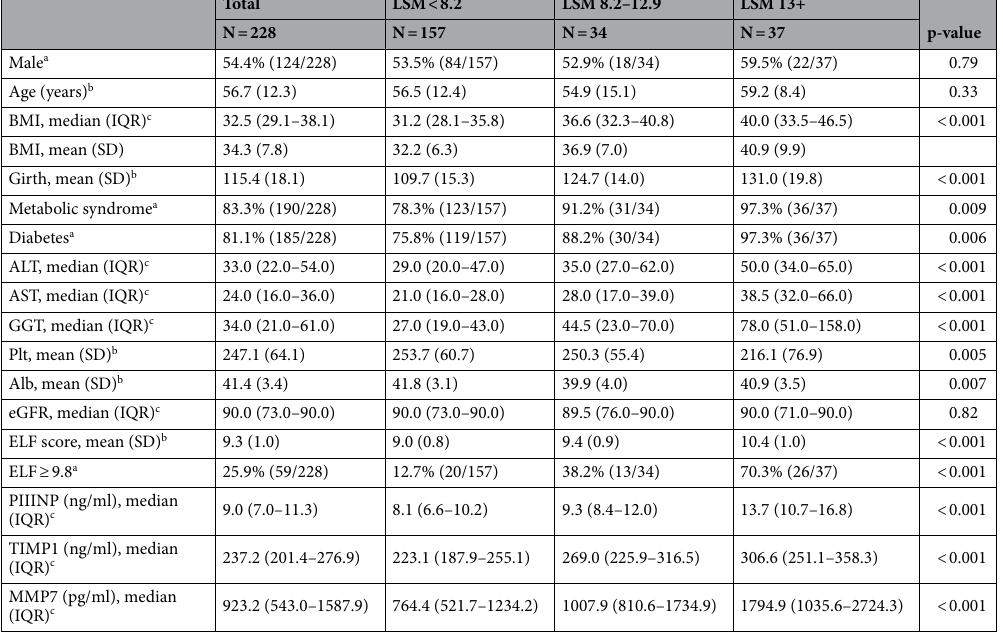
Table 1. Study cohort demographics and clinical parameters according to LSM category. Data are shown as mean (SD) or median (IQR) for continuous variables and count (%) for categorical variables. LSM: liver stiffness measurement, BMI: Body Mass Index, ALT: alanine aminotransferase, AST: aspartate aminotransferase, GGT: gamma-glutamyltransferase , Plt: platelet count (10 9 /L), ELF: enhanced liver fibrosis; HA: hyaluronic acid, TIMP1 tissue inhibitor of metalloprotease 1:, PIIINP: pro-collagen peptide III. a Chi- squared test. b One-way ANOVA. c Kruskal-Wallis